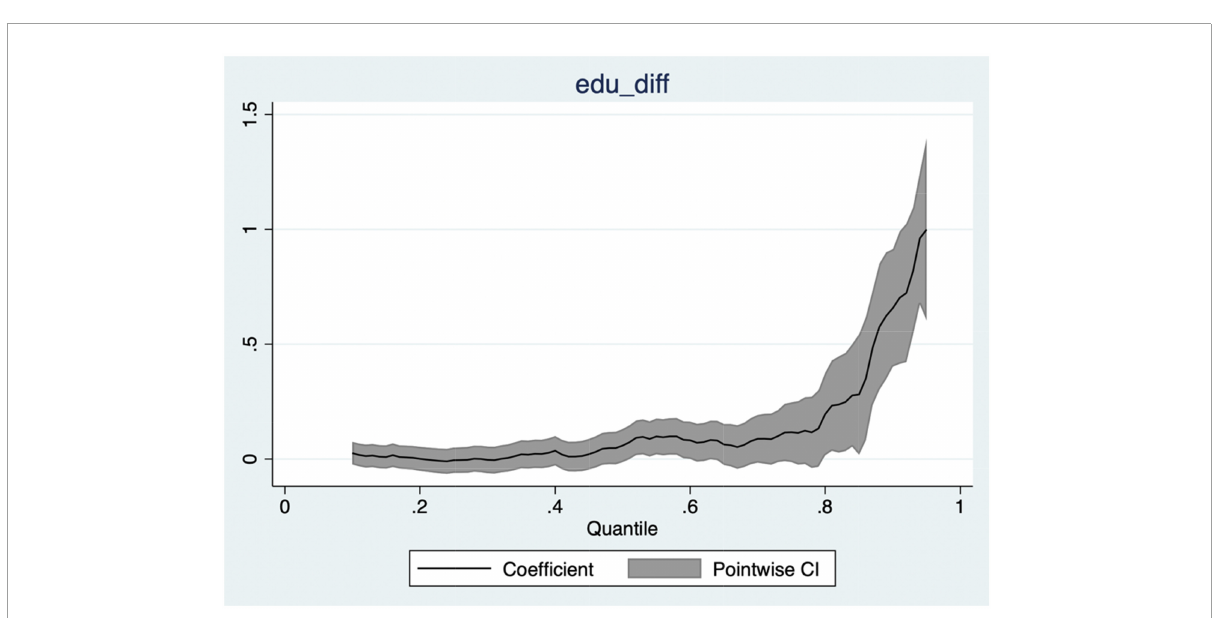
FIGURE3 Quantile regression coefficient